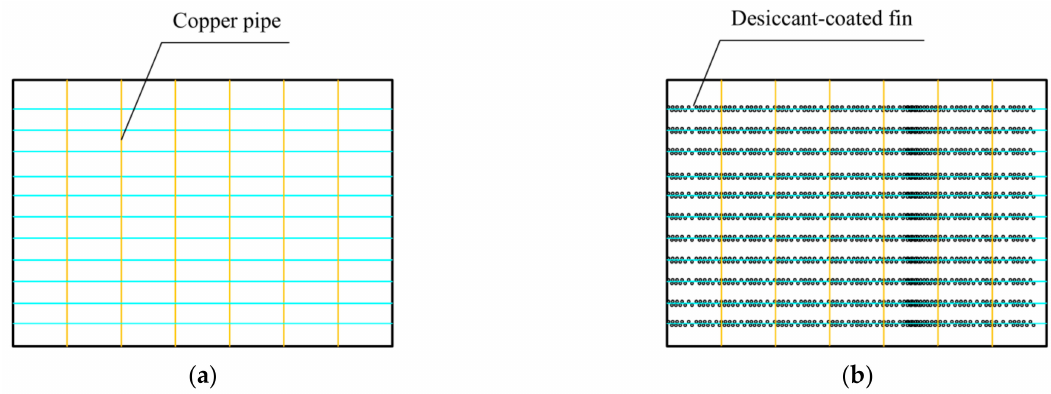
Figure 1. Fin tube heat exchanger: ( a ) Without desiccant coating; ( b ) with desiccant coating